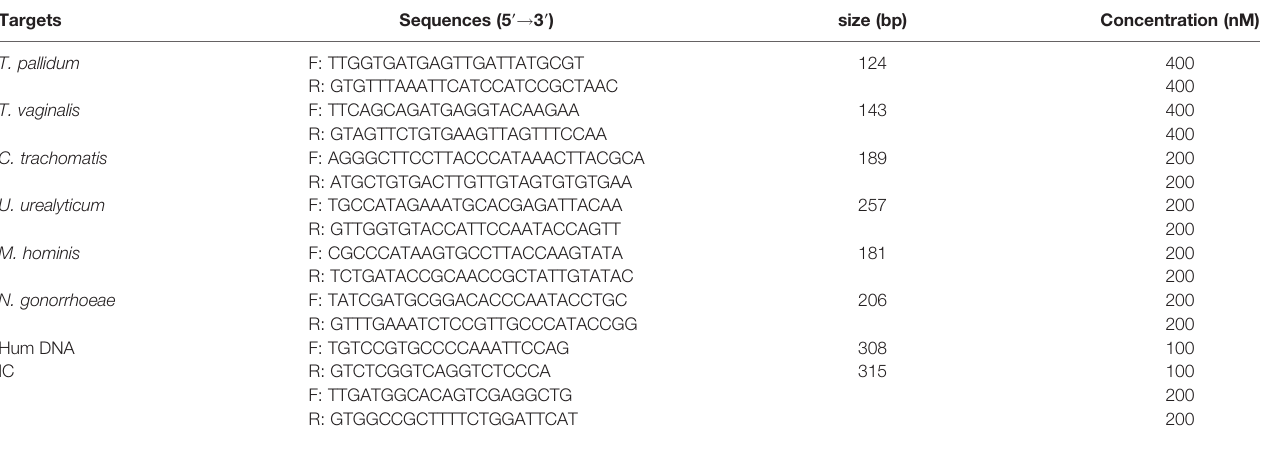
TABLE 1 | Target genes, primer sequences, and amplicon sizes, for STI-HMGS.